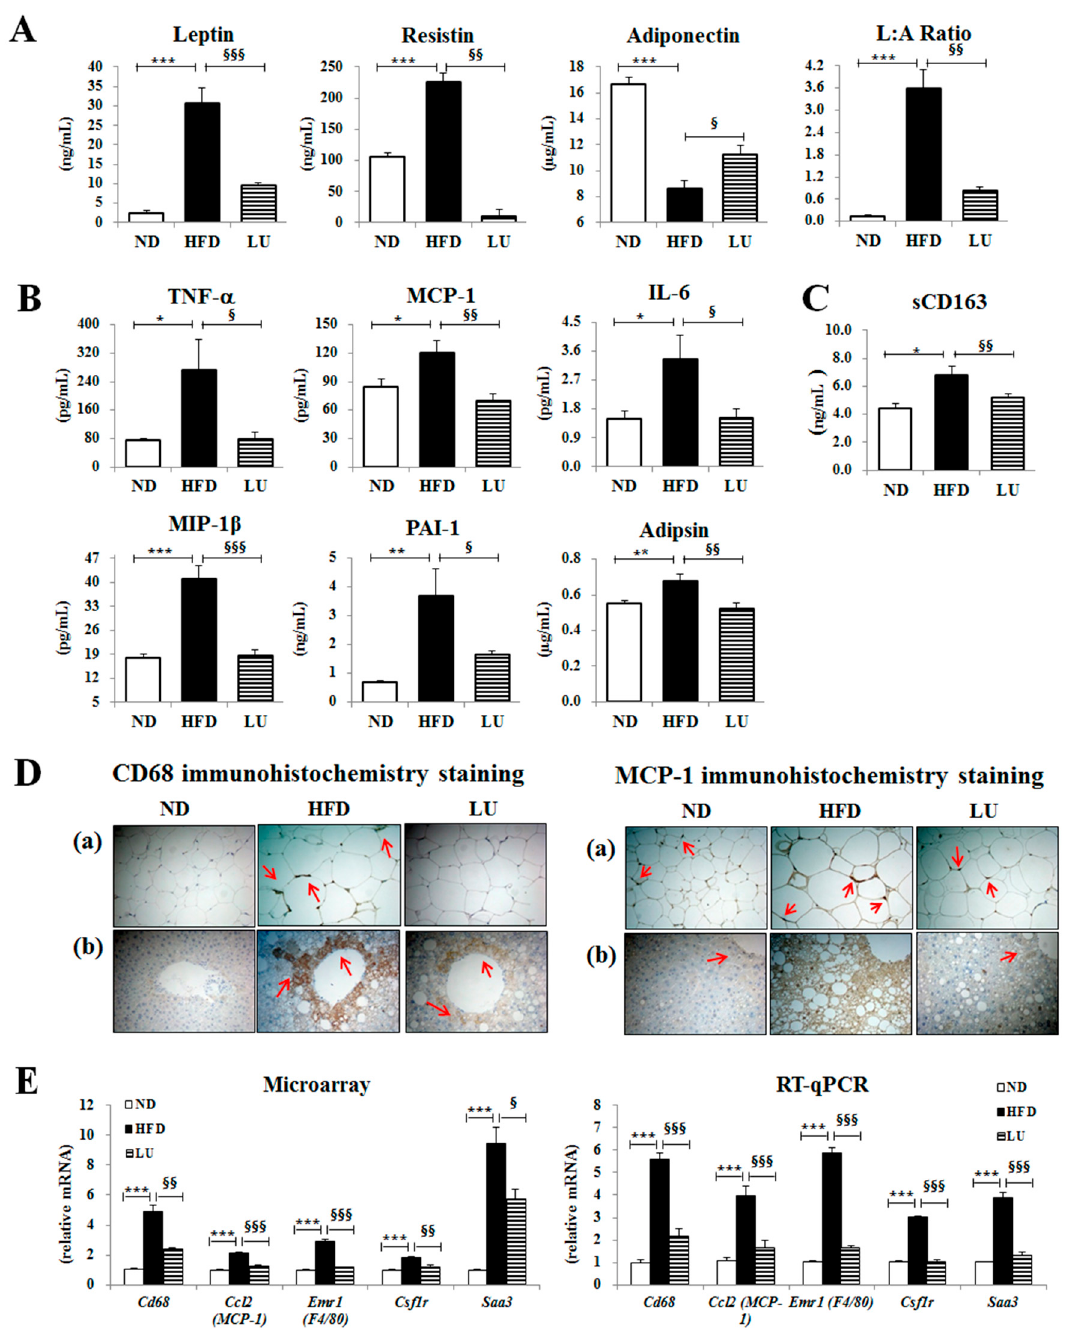
Figure 1. Effect of luteolin treatment for 16 weeks on the plasma adipokine/cytokine levels and macrophage-related markers in C57BL/6J mice fed the high-fat diet. ( A ) Levels of plasma adipokine leptin, resistin, and adiponectin, and the leptin/adiponectin ratio (L:A ratio). ( B ) Levels of plasma cytokines, TNF- α , MCP-1, IL-6, MIP-1 β , PAI-1, and adipsin. ( C ) Plasma level of the macrophage low-grade inflammation marker sCD163. ( D ) Immunohistochemistry staining for CD68 and MCP-1 of epididymal and liver sections (200 × magnification). ( E ) Adipocyte gene expression levels of Cd68 , Ccl2 , Emr1 , Csf1r , and Saa3 . Data are shown as means ± SEM. ND vs HFD: * p < 0.05, ** p < 0.01, *** p < 0.001. HFD vs LU: § p < 0.05, §§ p < 0.01, §§§ p < 0.001, ND, normal diet, HFD, high-fat diet, LU, Luteolin. The levels of the hepatic lipotoxicity markers, including plasma GOT and GPT, and hepatic mitochondrial H 2 O 2 and TBARS were markedly lower in the LU group than in the HFD